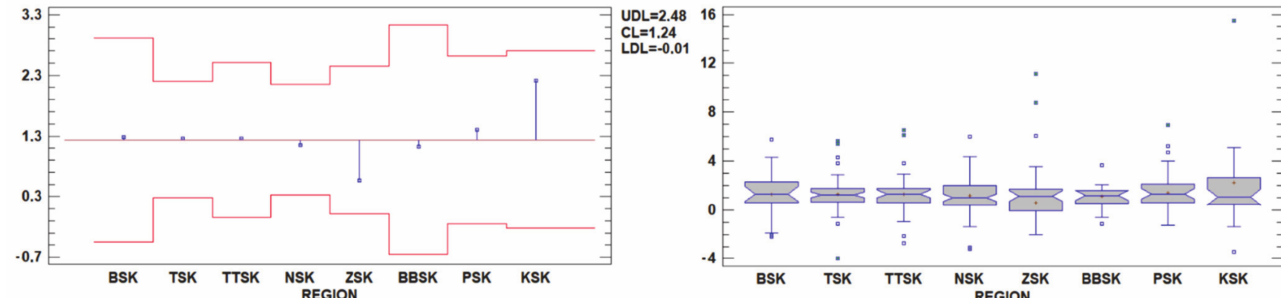
Figure 8. Comparison of the structure of results at the level of individual regions—Bonity index, agricultural cooperatives. Legend: BSK—Bratislava region, TSK—Trnava region, TTSK—Trenˇc í n region, NSK—Nitra region, ZSK—Žilina region, BBSK—Bansk á Bystrica region, PSK—Prešov region, KSK—Košice region; UDL—upper decision limit, CL—central line, LDL—lower decision limit.